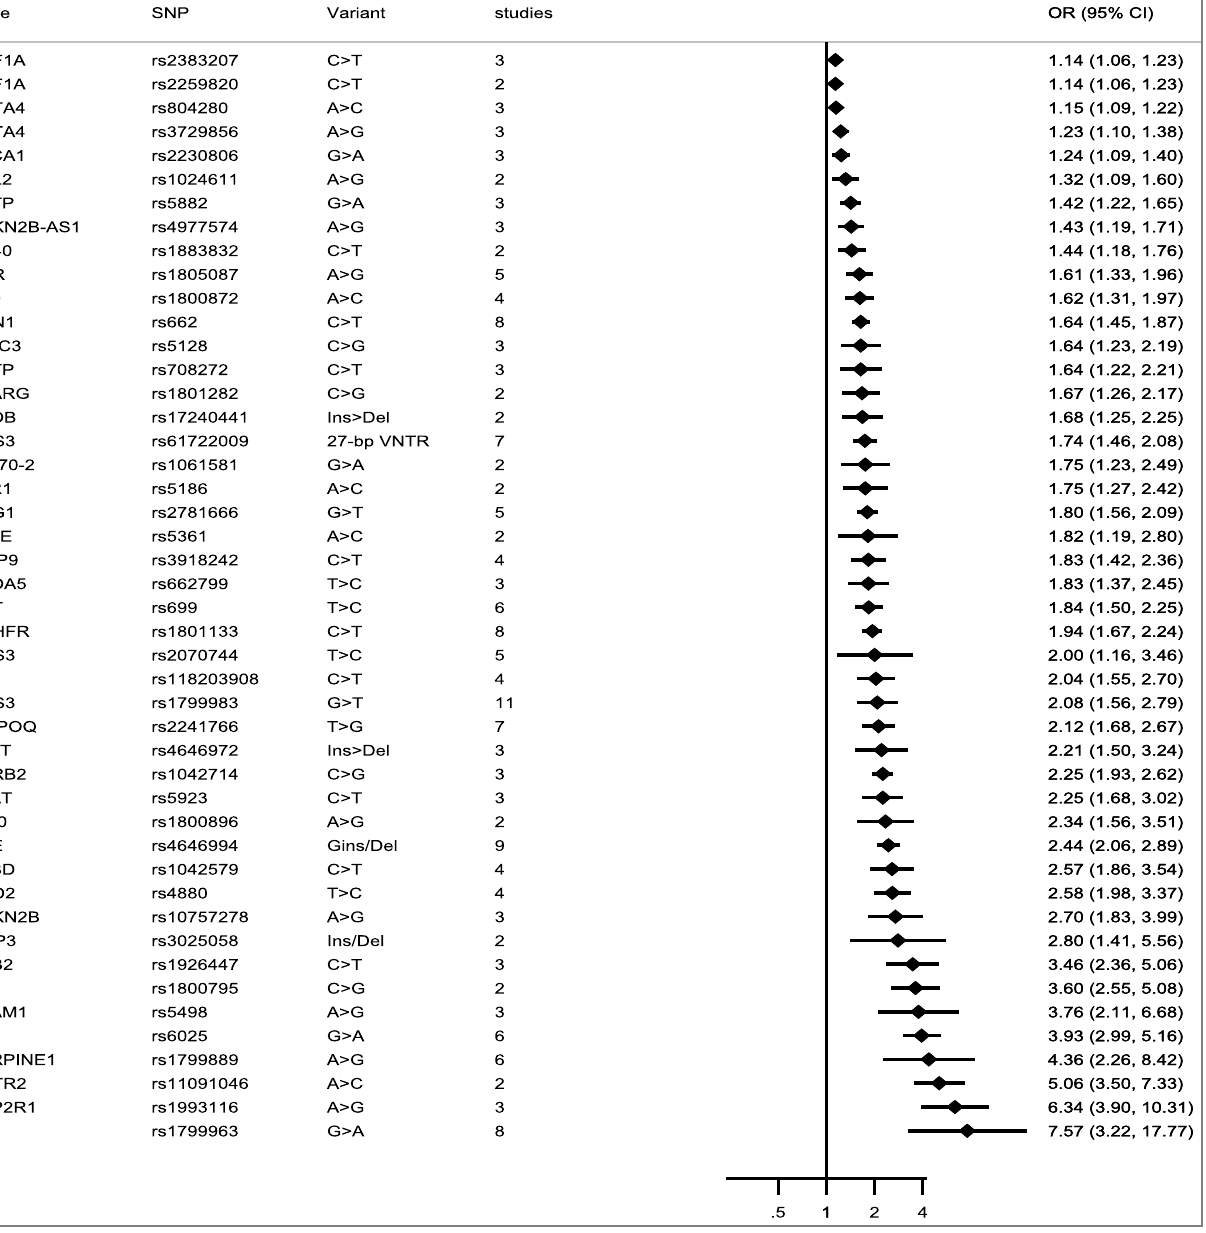
Figure 3. Summary of the 46 individual meta-analyses. 46 variants captured from 62 studies were individually meta-analyzed. The pooled OR of association with CAD/MI of all captured variants ranged from 1.14 to 7.57, with a median (interquartile range) of 1.83 (1.64 – 2.57). SNP: single nucleotide polymorphism; CI: confidence interval; OR: odds ratio.